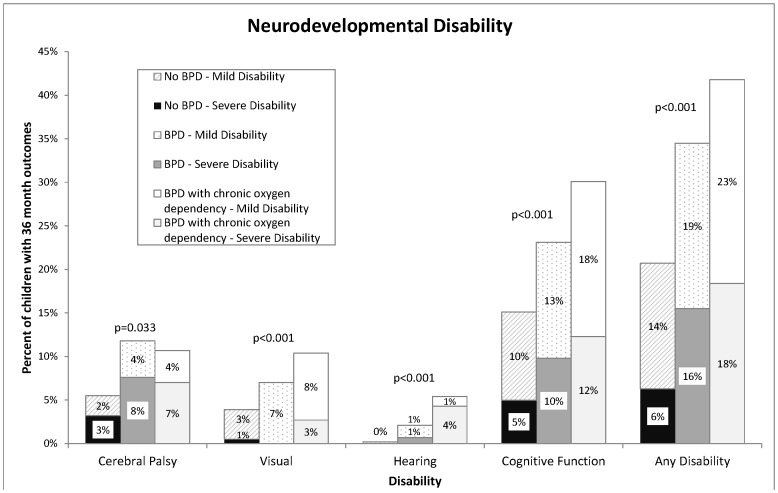
Disability Status at 36 Months Corrected Age.